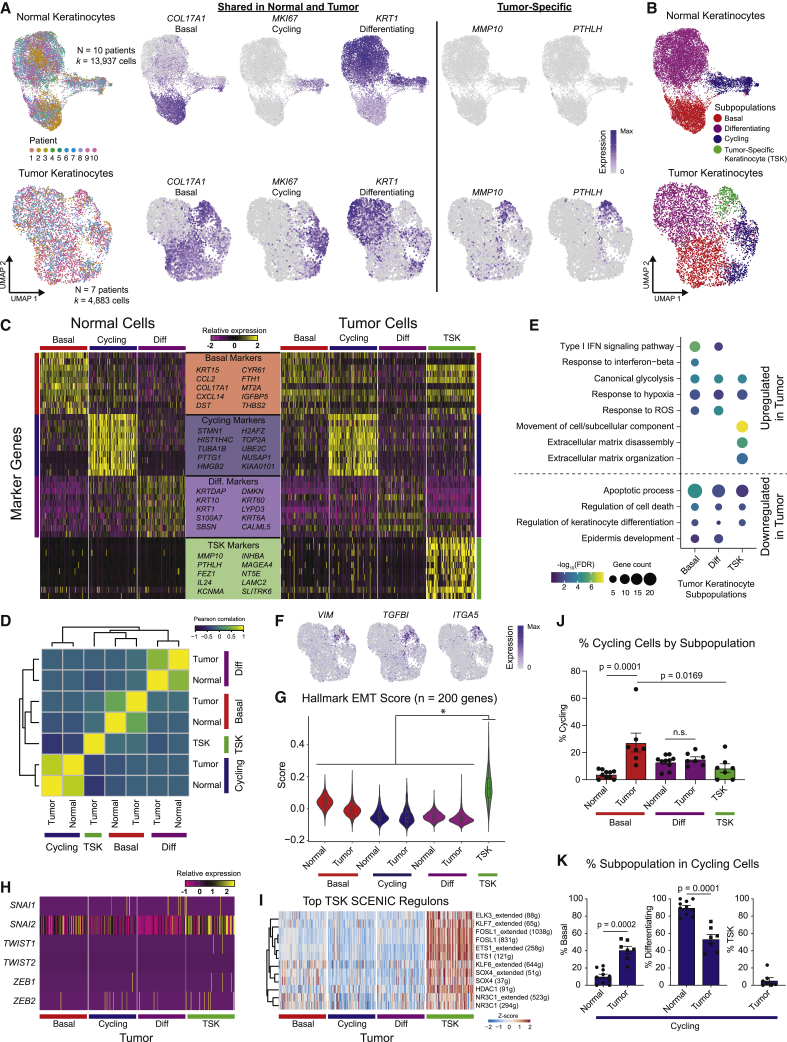
A Dysregulated Differentiation Hierarchy in Tumor Keratinocytes(A) Left, UMAP of normal keratinocytes (KCs) of the interfollicular epidermis and tumor KCs labeled by patient; middle, expression of basal, cycling, and differentiating genes found in both normal and tumor KCs; right, expression of tumor-specific genes.(B) UMAP classifying normal and tumor KCs into analogous basal, cycling, and differentiating clusters. Tumors contain a tumor-specific keratinocyte (TSK) subpopulation.(C) Expression of top 10 shared basal, cycling, differentiating, and TSK marker genes. TSK genes are minimally expressed in normal KCs.(D) Correlation matrix of overlapping differentially expressed genes (STAR Methods).(E) Dot plot of gene ontology (GO) terms for top 200 up- and downregulated genes in subpopulation differential expression for tumor versus normal KCs. TSK was compared to normal basal.(F) UMAP feature plots of expression for genes in hallmark epithelial-mesenchymal transition (EMT) signature in tumor KCs.(G) Violin plots of the hallmark EMT gene signature score in normal and tumor KC subpopulations. ∗p < 2.2 × 10−16 by pairwise Wilcoxon rank-sum tests with Benjamini-Hochberg correction.(H) Heatmap of expression of EMT-associated transcription factors in tumor KCs.(I) Heatmap of single-cell regulon scores inferred by SCENIC (g, genes; extended, SCENIC-annotated additional genes).(J) Bar plots of percentage of cycling cells per KC subpopulation after regressing cell-cycle signature from cycling cells.(K) Bar plots of percentage of subpopulation representation of KC cycling cells after cell-cycle regression.Data shown in (J) and (K) are averages ±SEM. Normal, n = 10 patients; tumor, n = 7 patients. p values were determined by Mann-Whitney U test. For visualization, a random sampling of 100 cells per subpopulation are shown in (C), (H), and (I). See also Figure S2 and Tables S2 and S3.